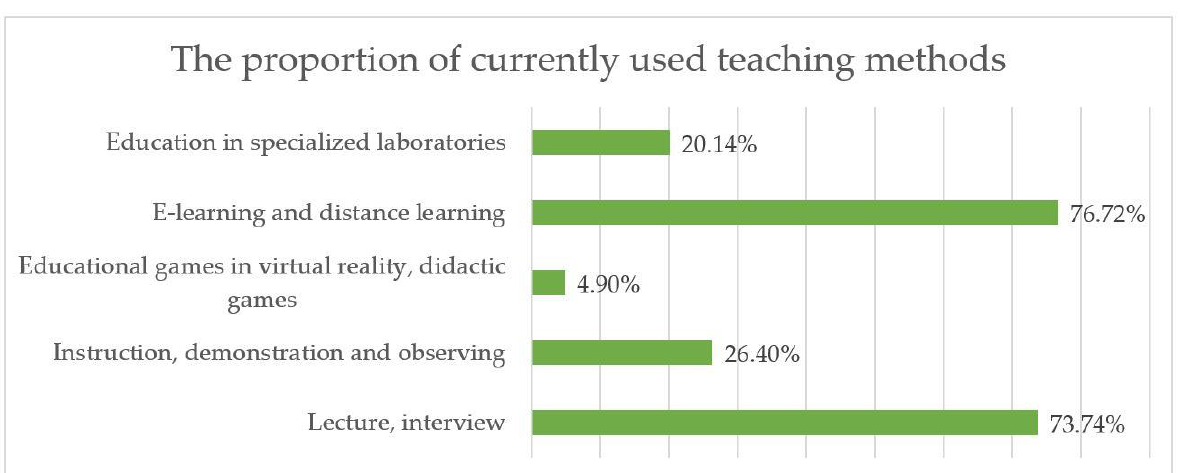
Figure 11. The proportion of currently used teaching methods.